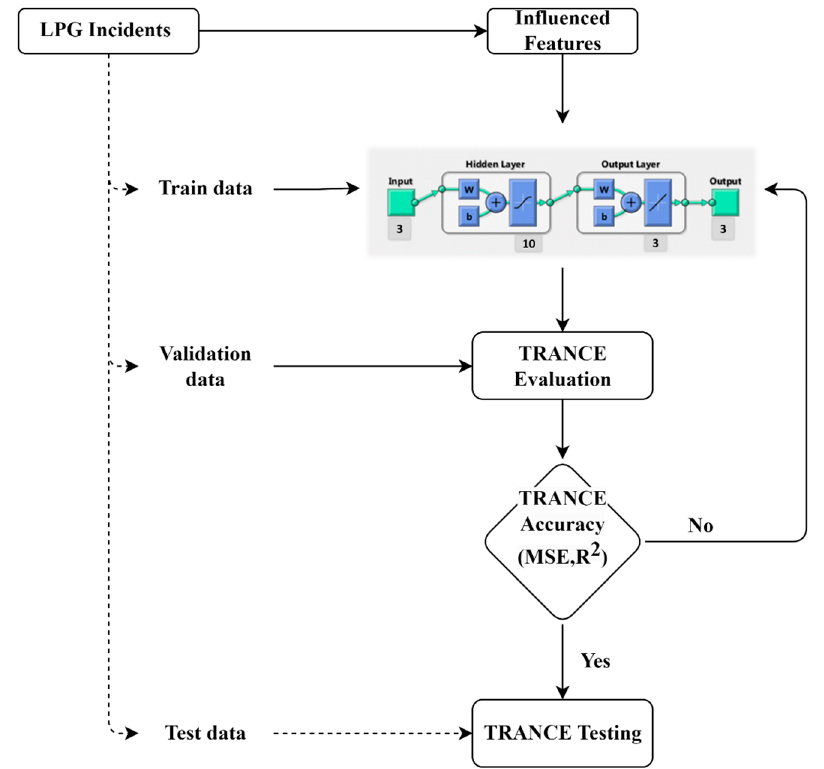
Figure 1. Systematic quantitative risk analysis of LPG plant using ANN methodology chart .